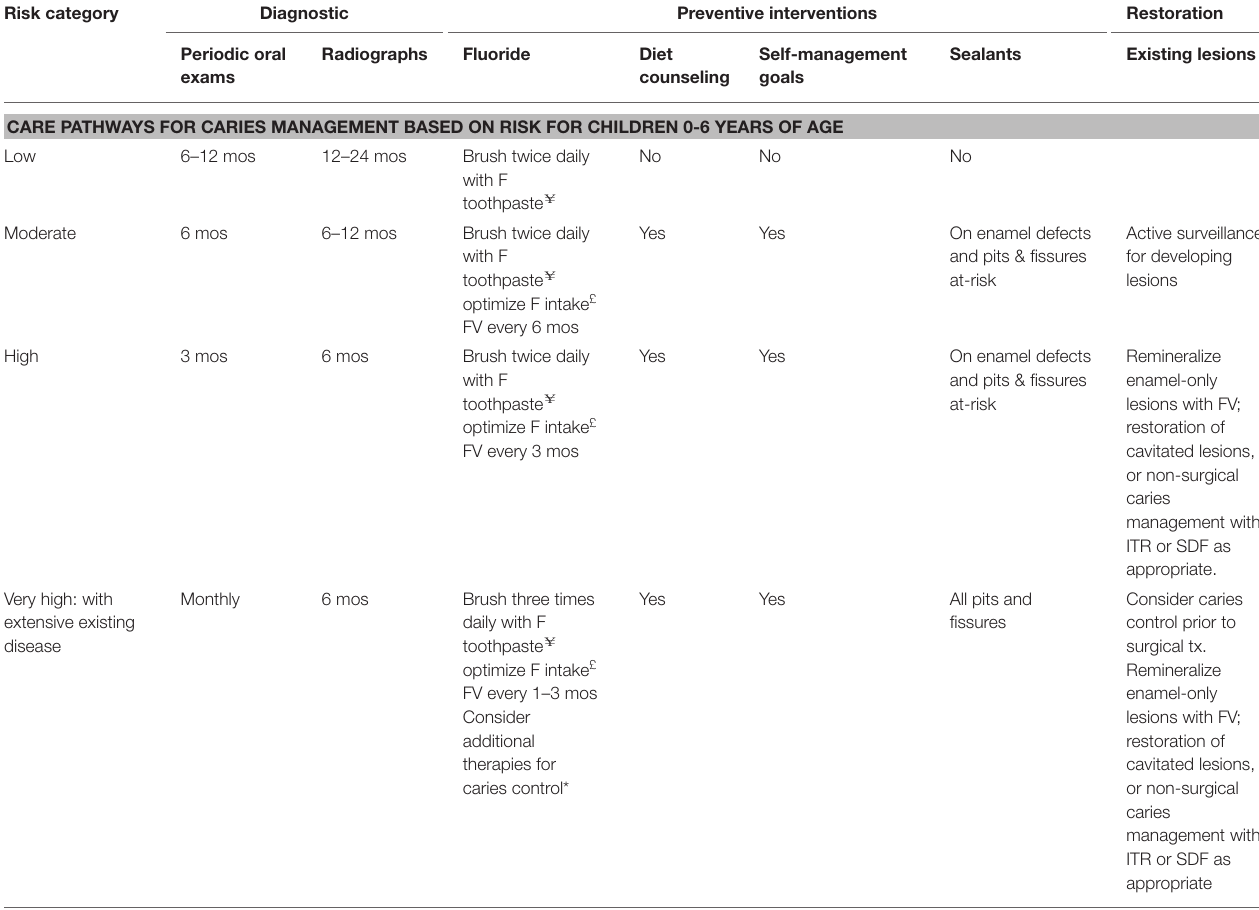
TABLE 3 | Care pathways for caries management based upon risk assessment for ages 0–6 years.